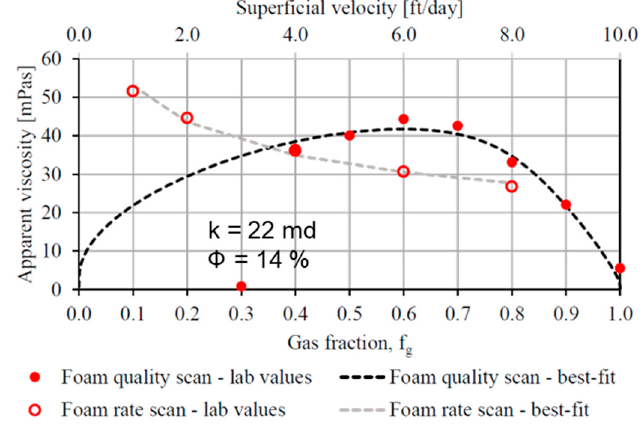
Figure 3. Laboratory foam quality (red filled circles) and rate (red open circles) scans used to derive foam model parameters for the local equilibrium foam model. The dashed lines show the model fit.